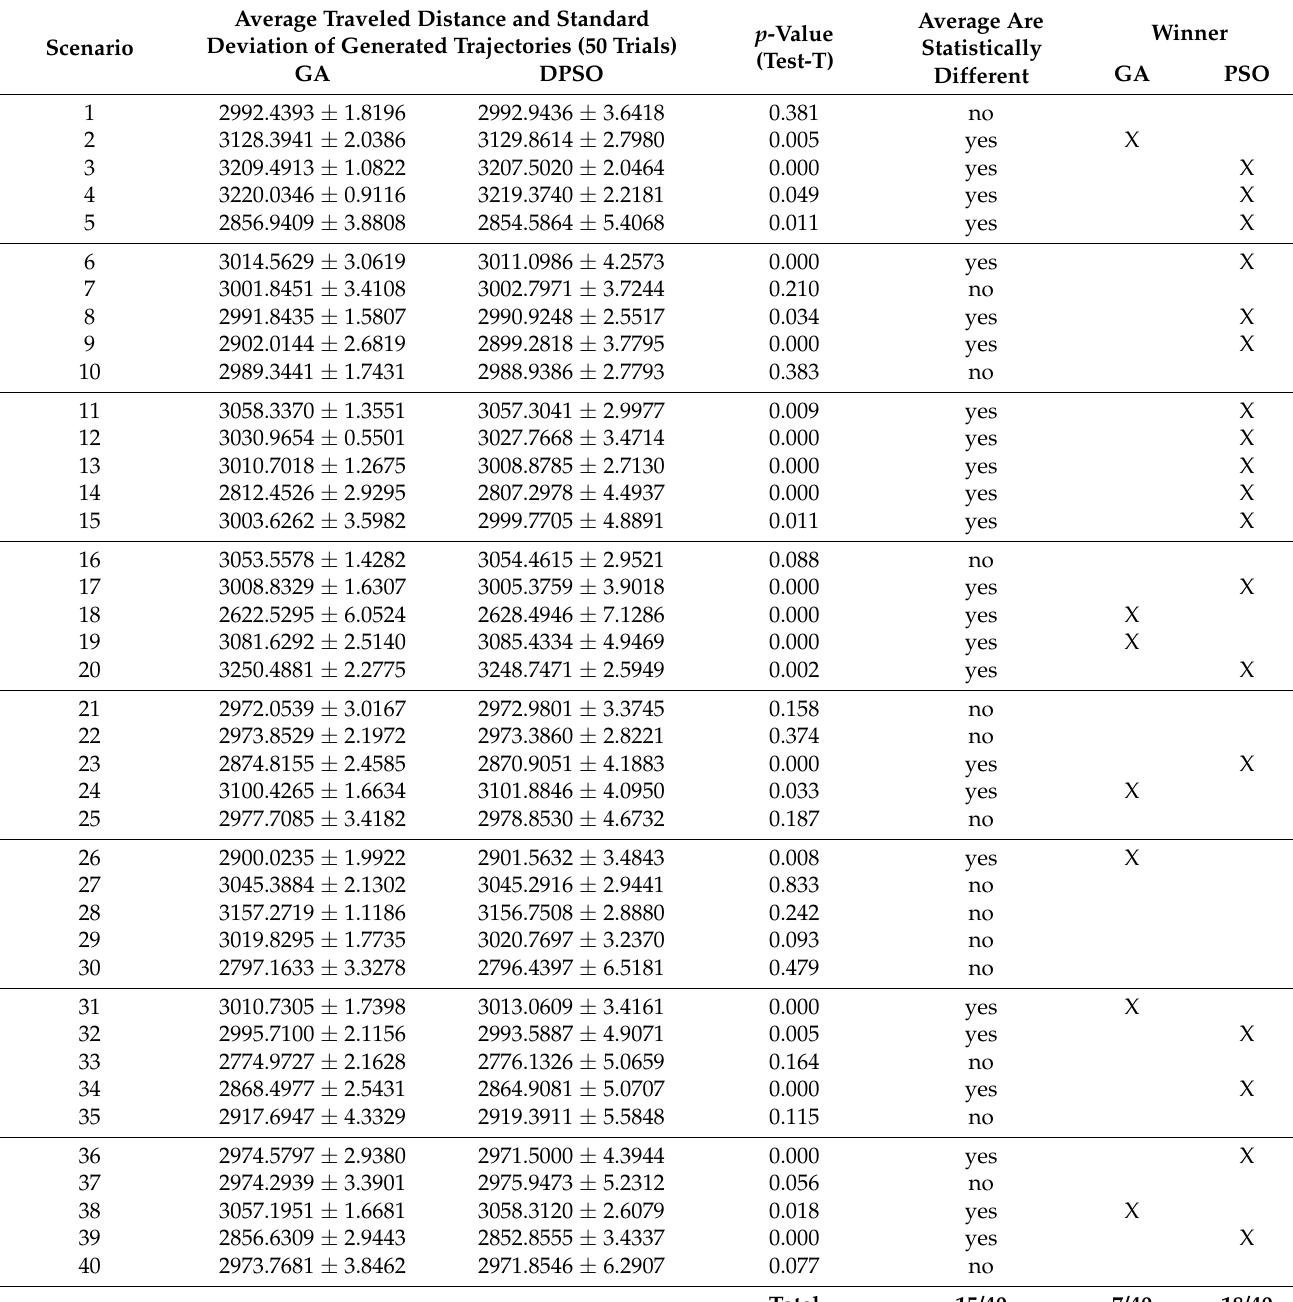
Table 2. Average traveled distance of the 50 trajectories generated for each of the 40 scenarios using the GA and DPSO algorithm when n = 40 and m =